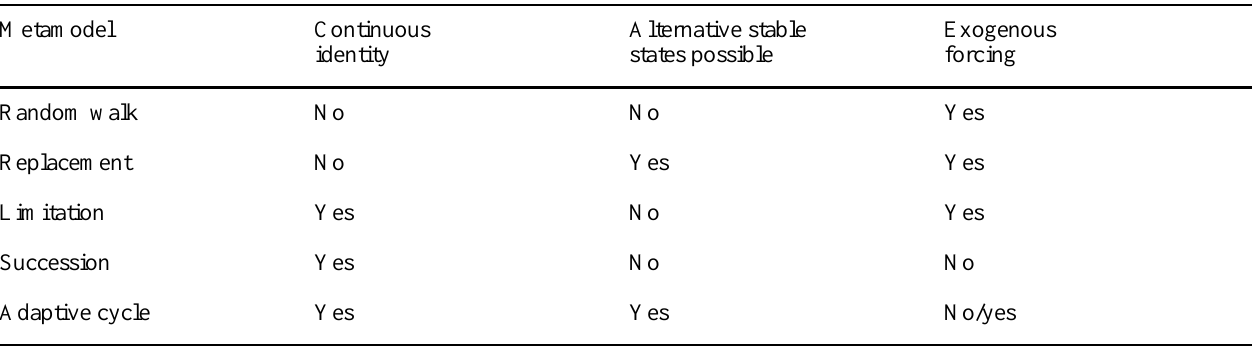
Table 1. A provisional categorization of metamodels according to their defining characteristics. They can be distinguished on the basis of whether the system maintains a continuous identity through time; whether alternative stable states (implying some form of self-reinforcement) are possible in the same physical location; and whether the role of exogenous variables is strong or weak. As explained previously, the evolution model is excluded because we do not regard it as an appropriate whole-system model for ecosystems, societies, and